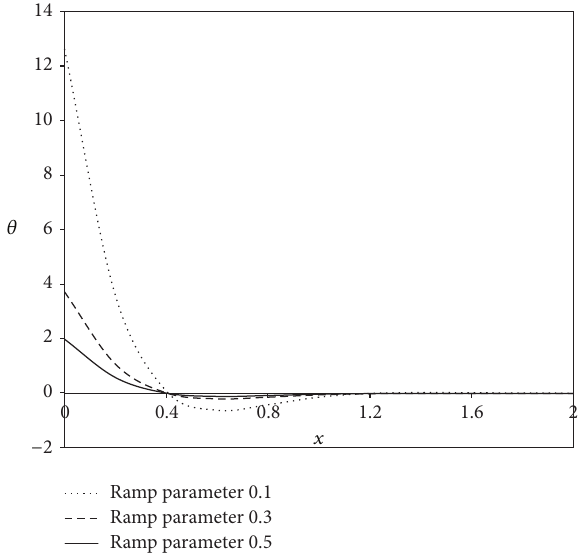
Figure 8: Temperature distribution 𝜃 for different values of ramp parameter at 𝛼 = 0.5 , 𝑡 = 0.1 .